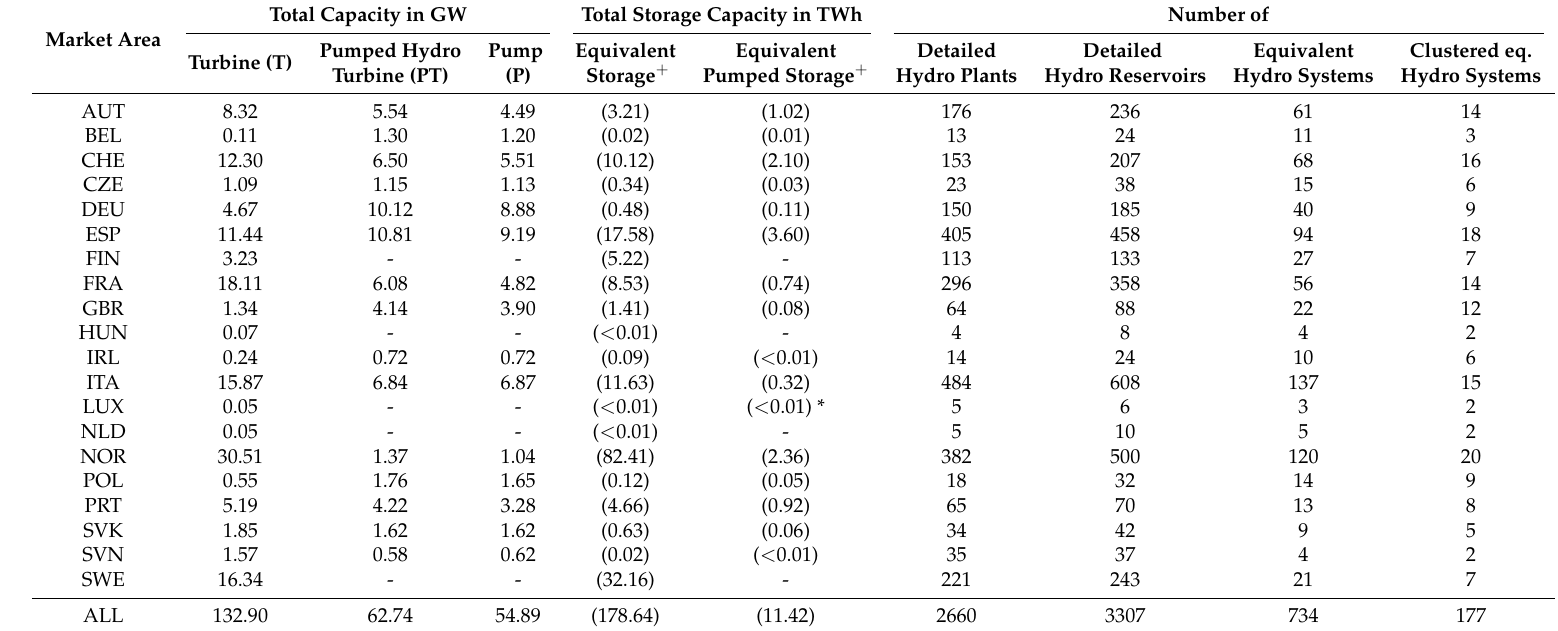
Table 2. Hydropower characteristics for all three model variants based on the collected bottom-up data for all considered market areas across Europe.